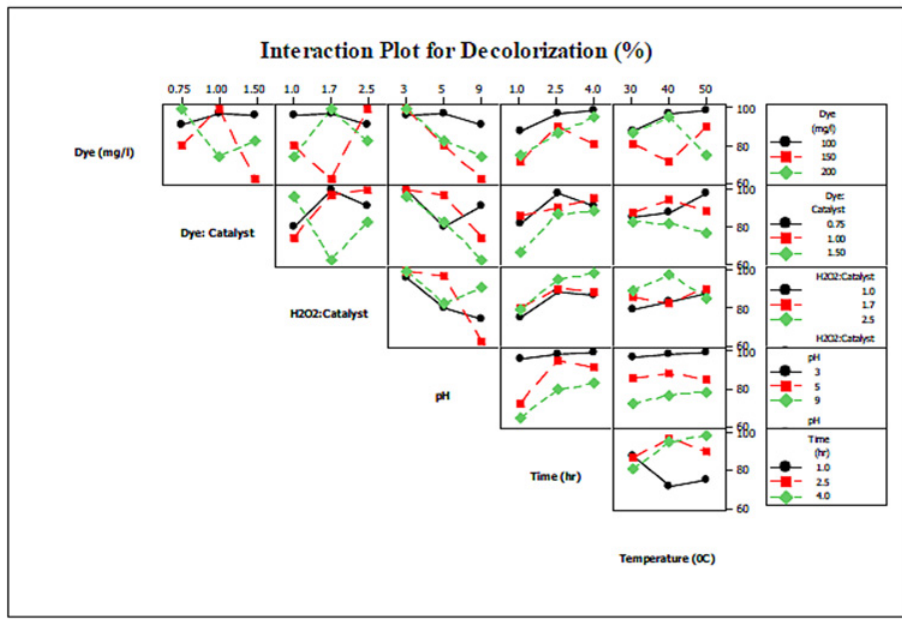
Fig 6. Interaction of parameters with respect to decolorization.